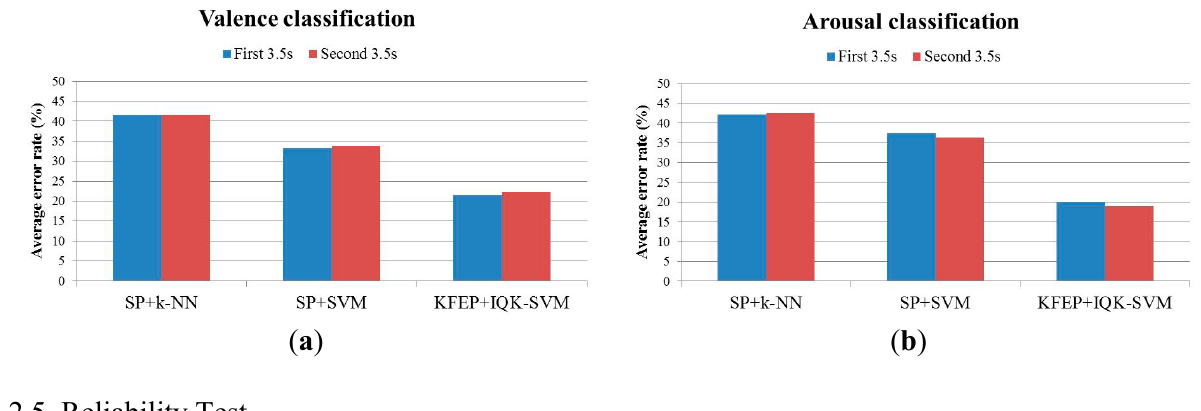
Figure 8. Comparison of average error rates between the first and second 3.5-s for different methods: ( a ) valence and ( b ) arousal